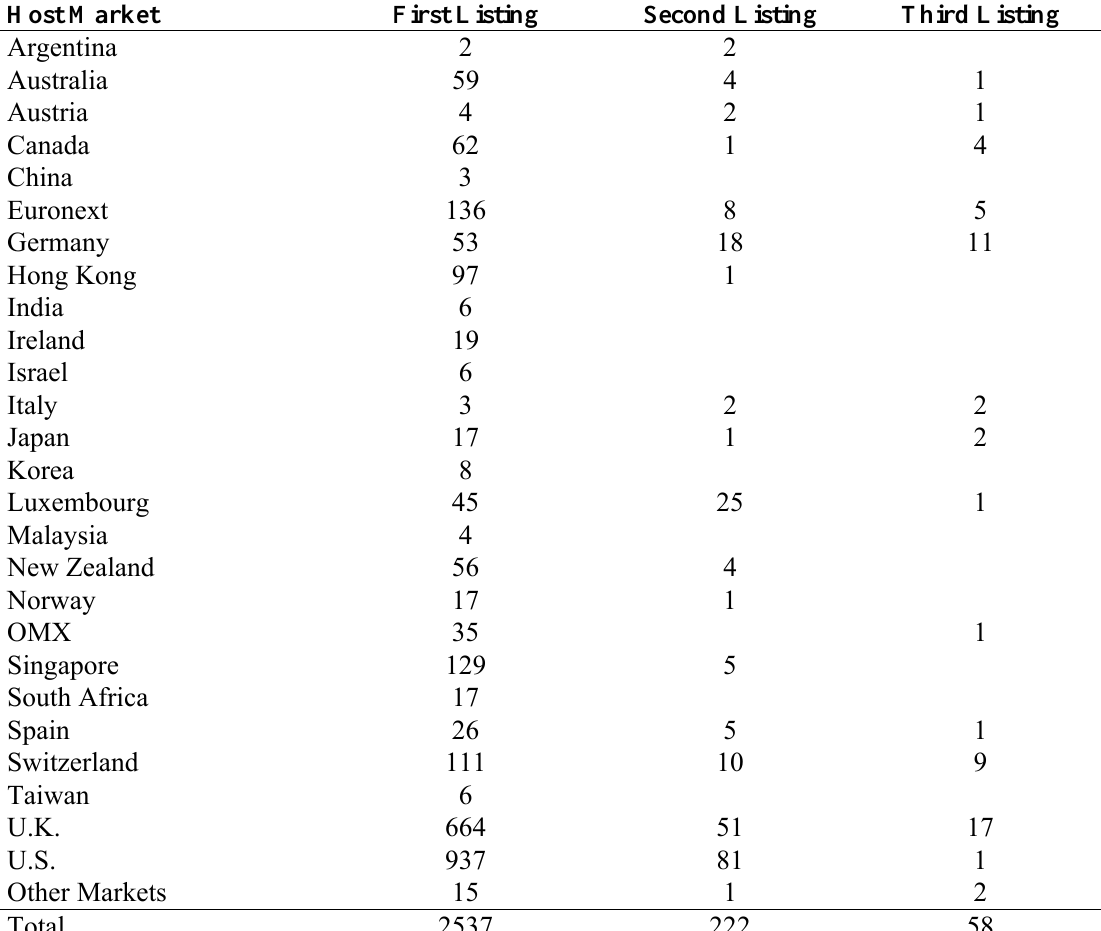
Table 2. Destinations for the Sample of Cross-Listed